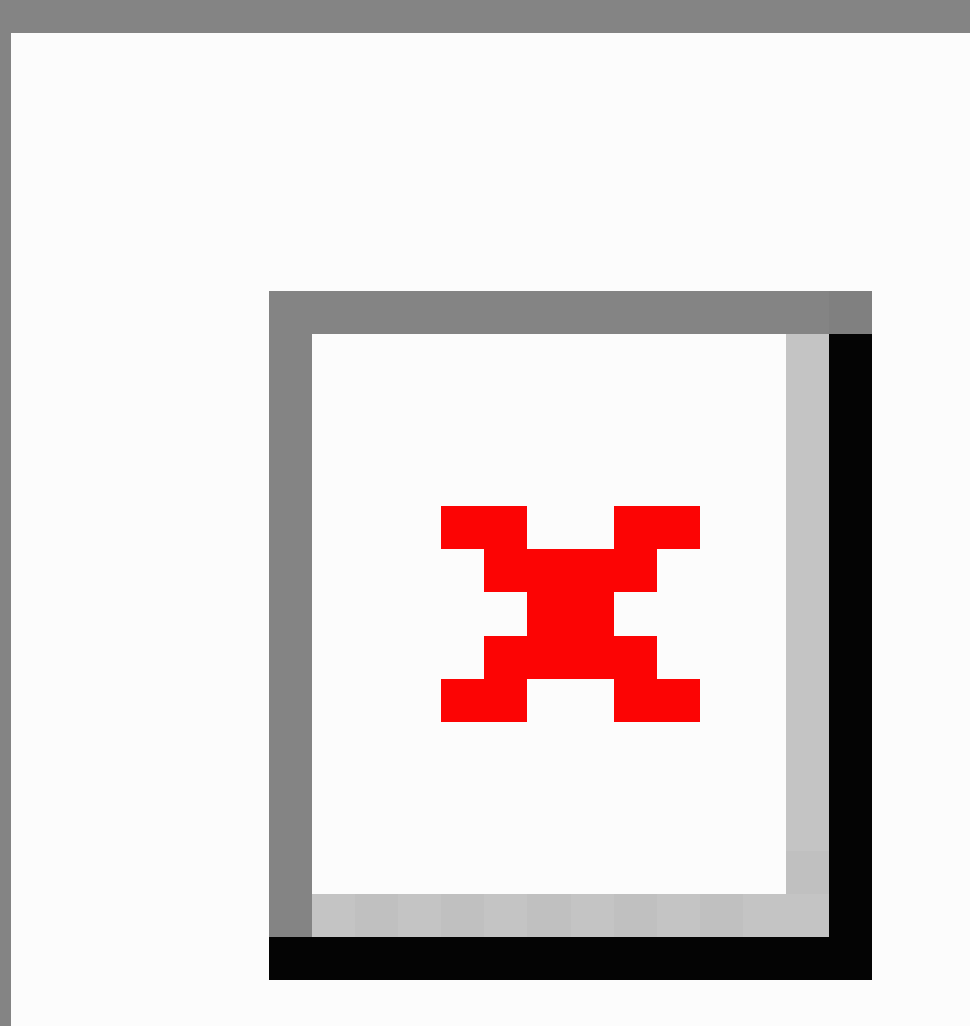
Figure 4. Total number of weekly and monthly active fans, on QAF Facebook page from Series